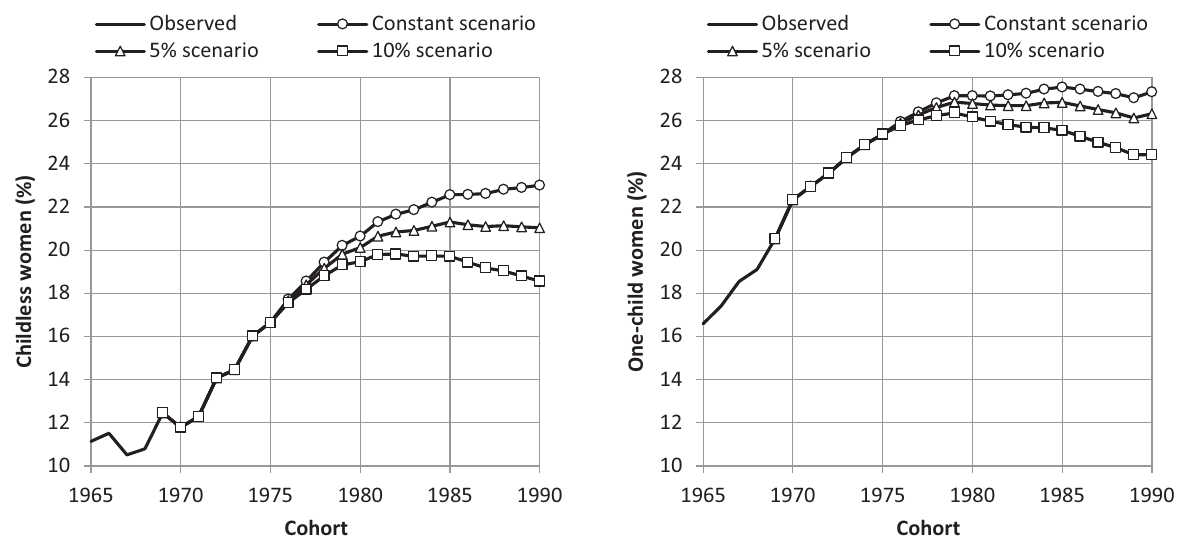
Figure 4. Observed and projected childlessness (left) and one‐child (right) families in Slovakia in various scenarios: 1969–1990 cohorts. Source: Author’s calculations based on Statistical Office of the Slovak Republic (1992–2020, 2021a).